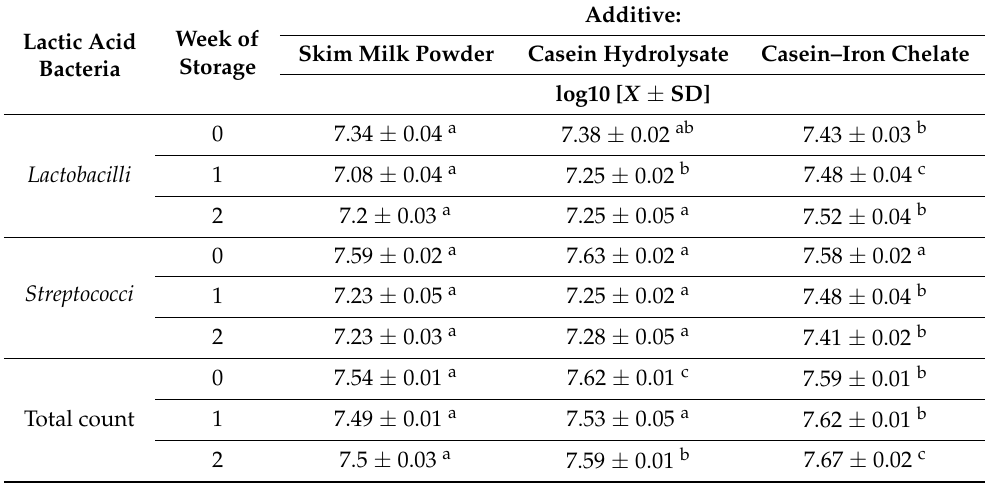
Table 3. Count of lactic acid bacteria [log10] in yoghurts produced with the addition of skim milk powder, casein hydrolysate, and protein–iron chelate during the storage. Additive: Week of Lactic Acid Skim Milk Powder Casein Hydrolysate Casein–Iron Chelate Storage Bacteria log10 [ X ± SD] 0 7.34 ± 0.04 a Lactobacilli